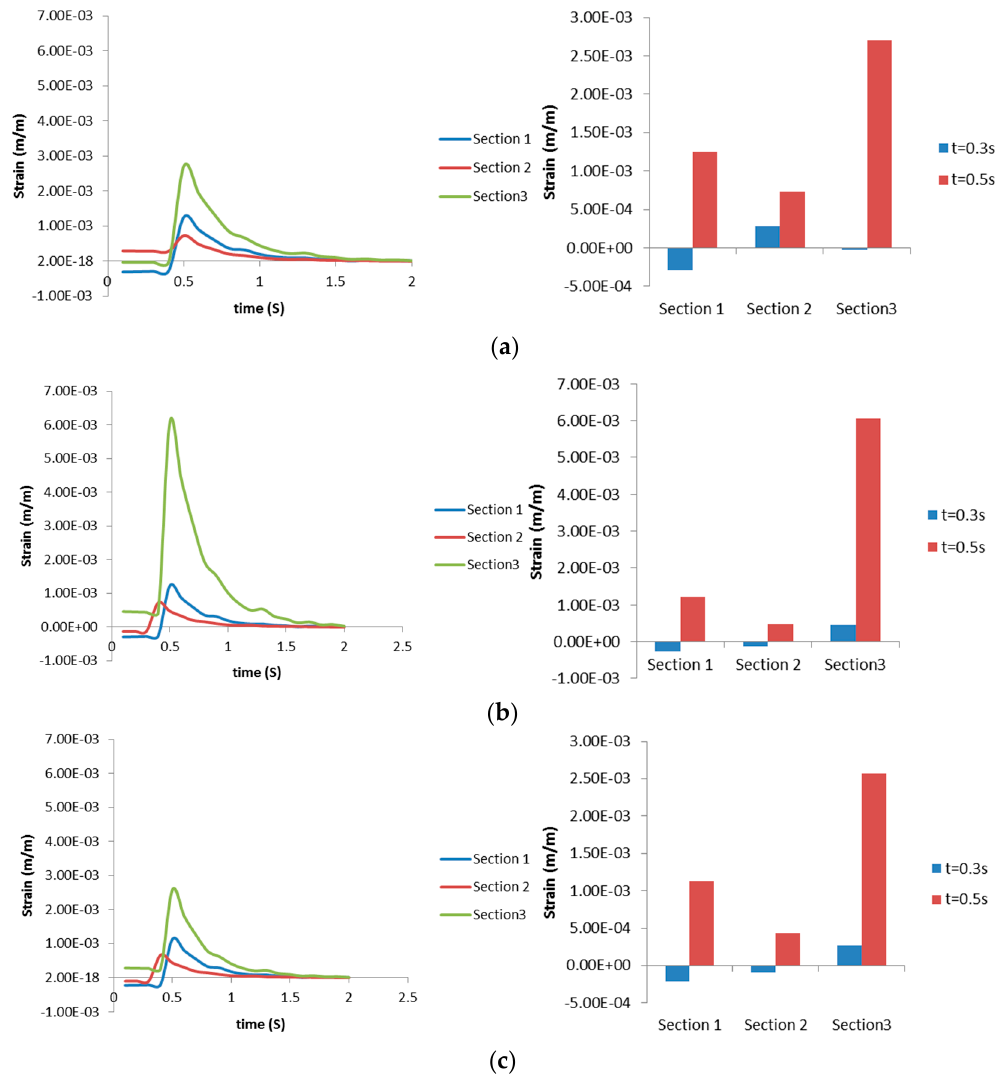
Figure 7. Maximum Von Mises strains in ( a ) Layer 1; ( b ) Layer 2; and ( c ) Layer 3. Right column shows strain progression over time, left column captures the Von Mises strain at a specific time for a clearer comparison.